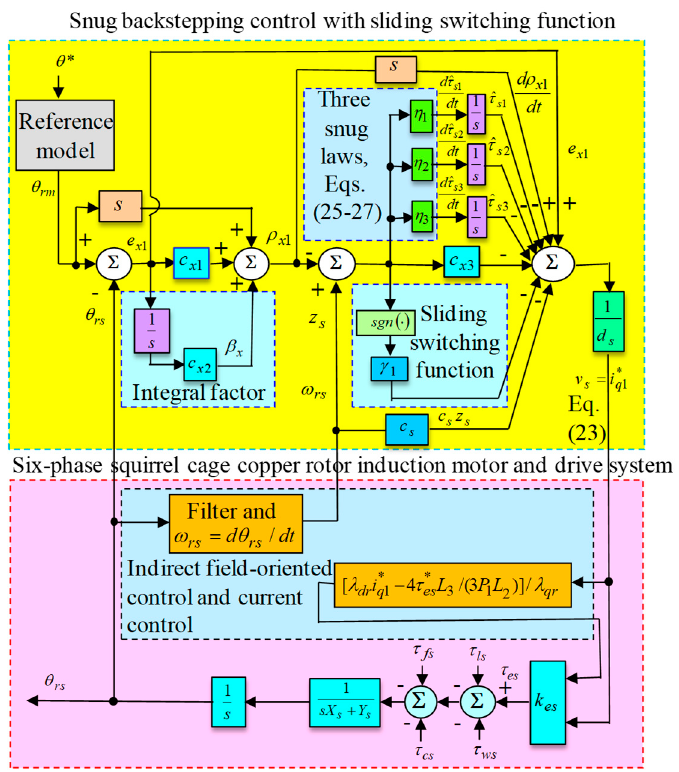
Figure 3. Control block diagram of the snug backstepping control with a sliding switching function.